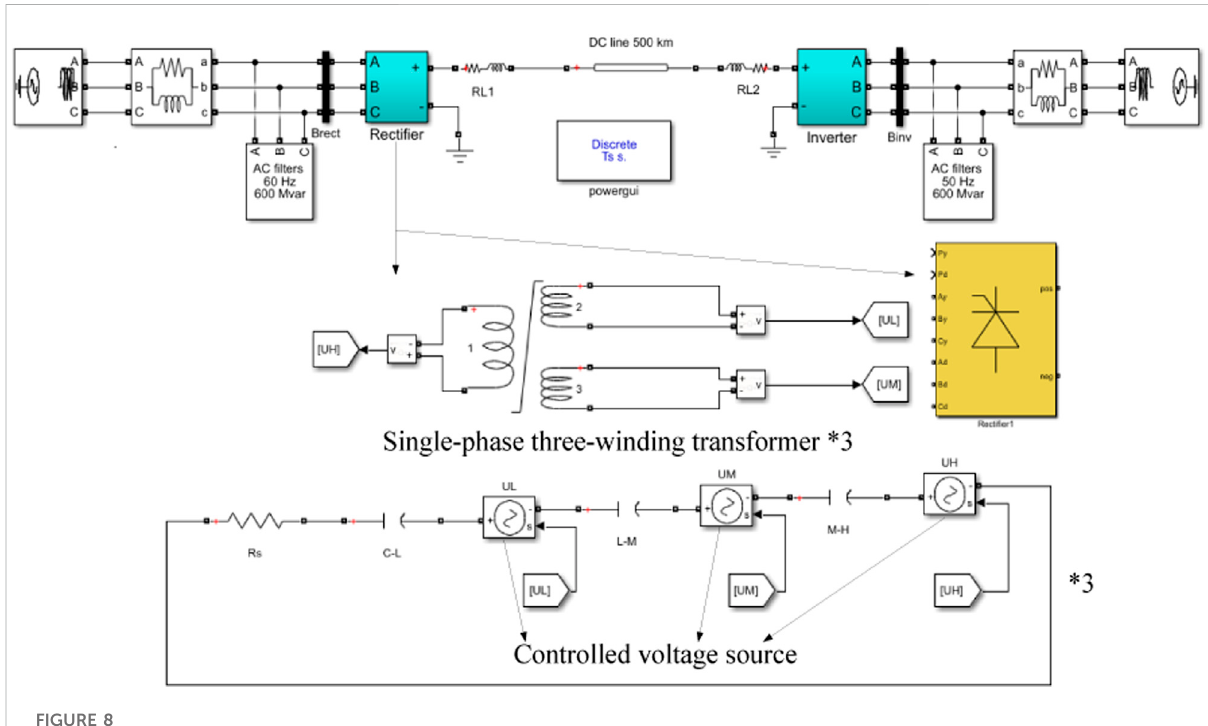
FIGURE 8 Simulation circuit converter